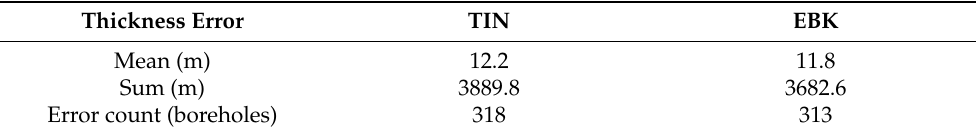
Table 4. Thickness error results at the locations of 1122 boreholes known not to reach the bedrock.